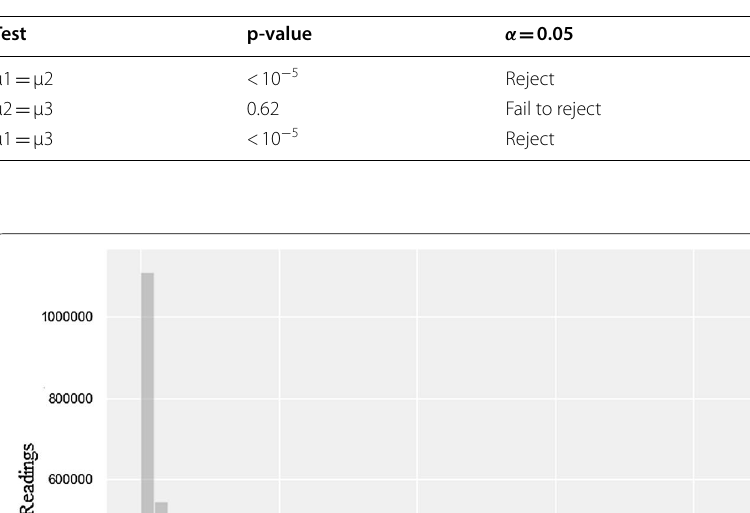
Table 10 T test—results